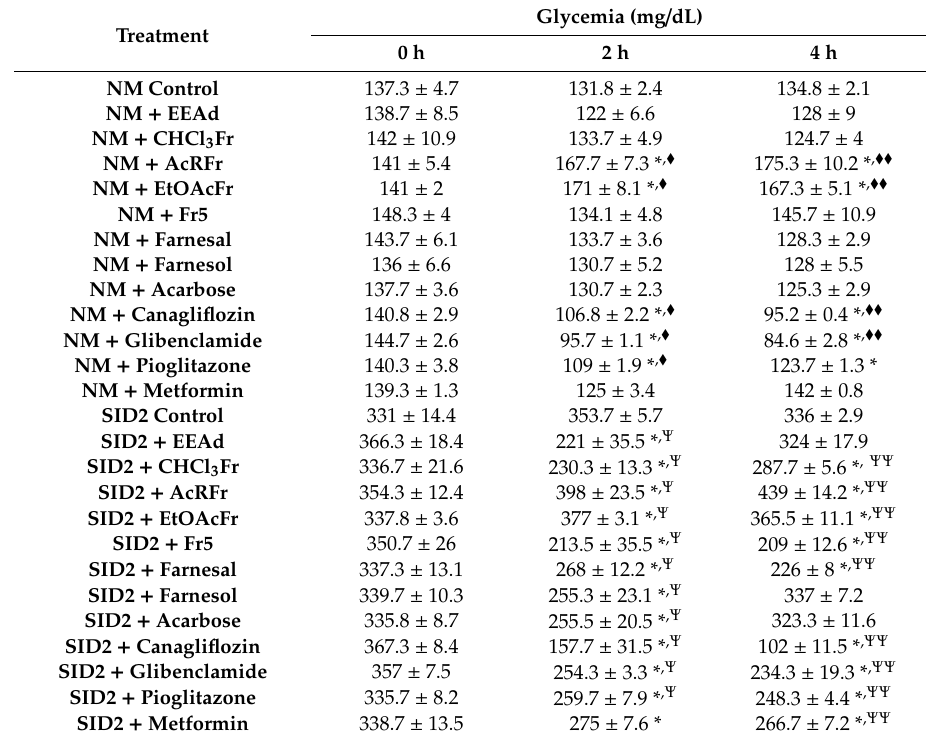
Table 1. Blood glucose levels of male normoglycemic mice (NM) and streptozocin-induced type 2 diabetes mice (SID2) at 0, 2 and 4 h on the acute antihyperglycemic test.